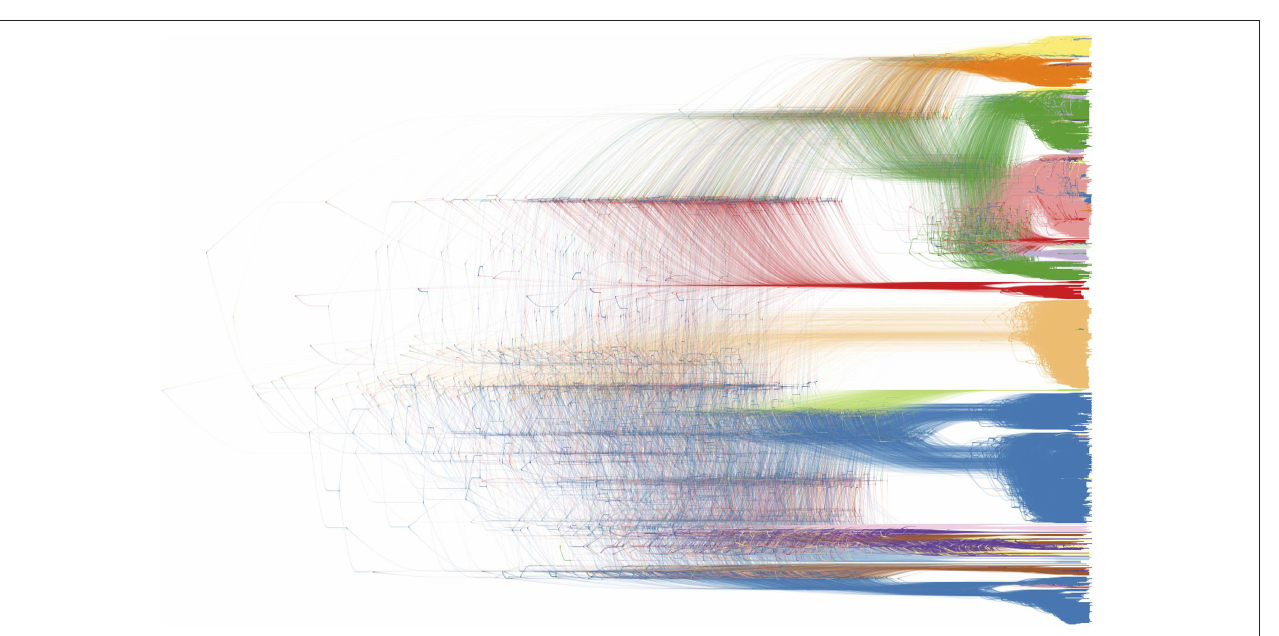
FIGURE 10 | Bayesian phylogenetic inference software packages generate a large number of posterior trees, potentially annotated with inferred ancestral traits. This collection of trees is often summarized using a consensus tree, allowing to plot a single tree with posterior support values on the internal nodes. DensiTree enables drawing all posterior trees in the collection; areas where a lot of the trees agree in topology and branch lengths show up as highly colored areas, while areas with little agreement show up as webs (39). We refer to Figure 2 for the color legend of the host species, as the legend drawn by DensiTree was not very readable and could not be edited (in terms of its textual